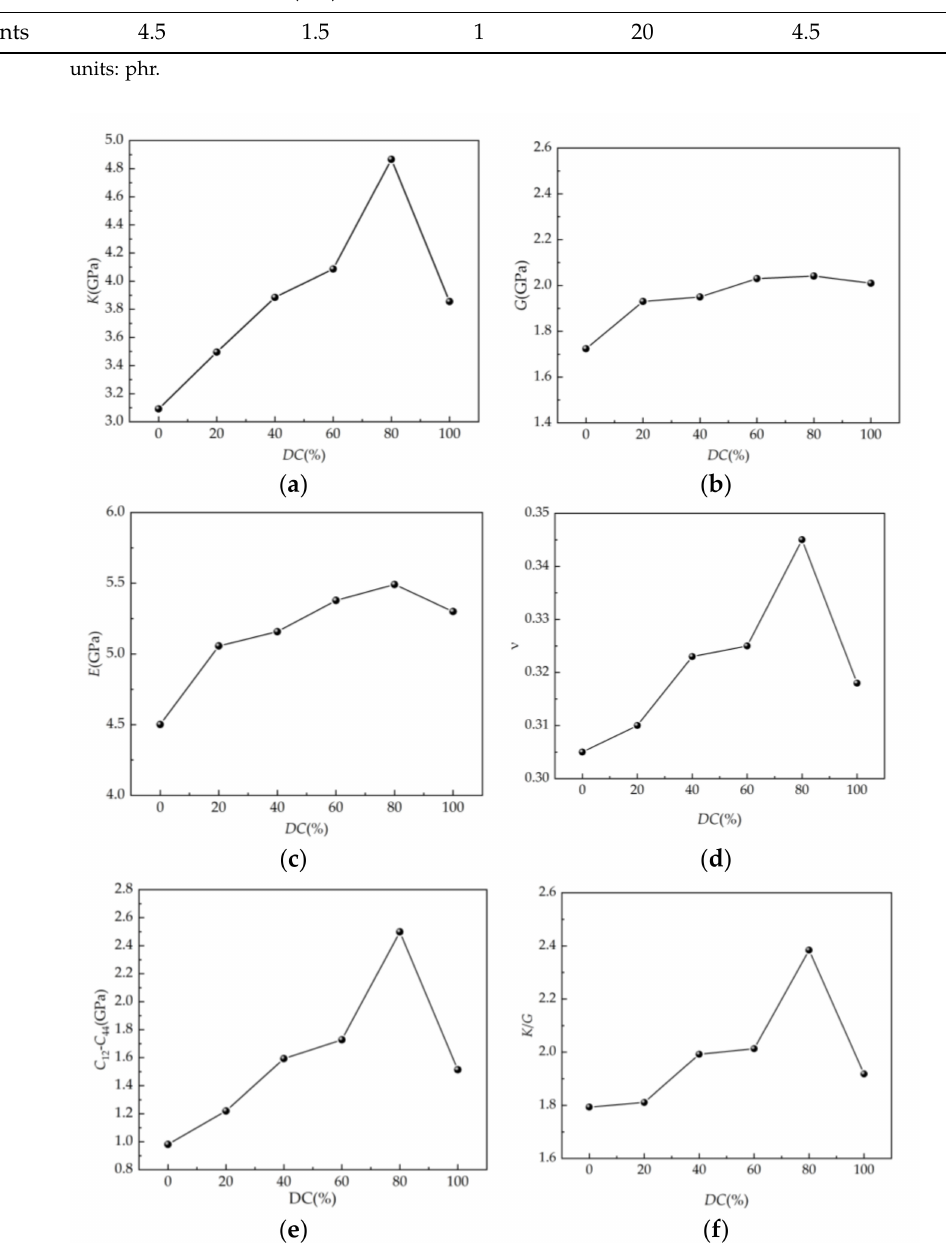
Figure 17. Relationship between cross-linking degree and mechanical parameters: ( a ) relationship between cross-linking degree and bulk modulus; ( b ) relationship between cross-linking degree and shear modulus; ( c ) relationship between cross-linking degree and elastic modulus; ( d ) relationship between cross-linking degree and Poisson ratio; ( e ) relationship between cross-linking degree and C 12 - C 44 ; ( f ) relationship between cross-linking degree and K / G